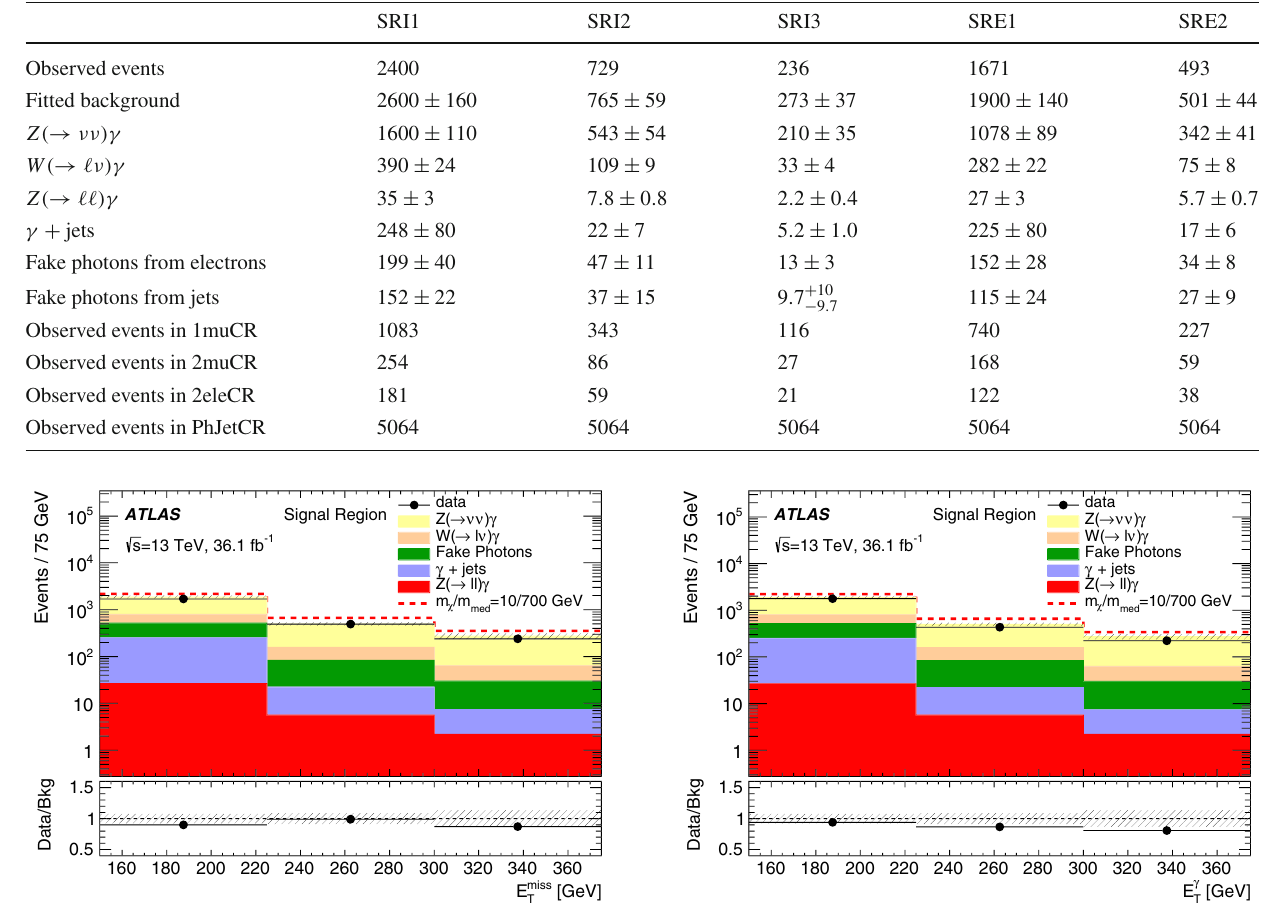
γ Fig. 3 Distributionof E miss uncertainties determined by the fit. The expected yield of events from ( left )andof E ( right )inthesignalregions T T the simplified model with m χ = 10 GeV and an axial-vector mediator for data and for the expected total background; the total background expectation is normalised using the scale factors k (cid:7) derived from the of mass m med = 700 GeV with g q = 0 . 25 and g χ = 1 . 0 is stacked on multiple-bin fit. Overflows are included in the third bin. The error bars top of the background prediction. The lower panel shows the ratio of are statistical, and the dashed band includes statistical and systematic data to expected background event